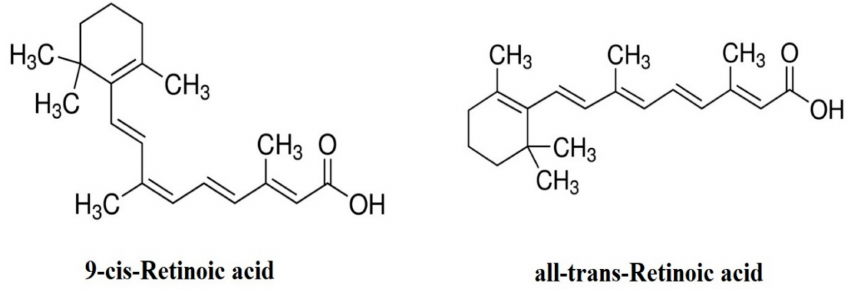
Figure 1. Retinoic acid forms.